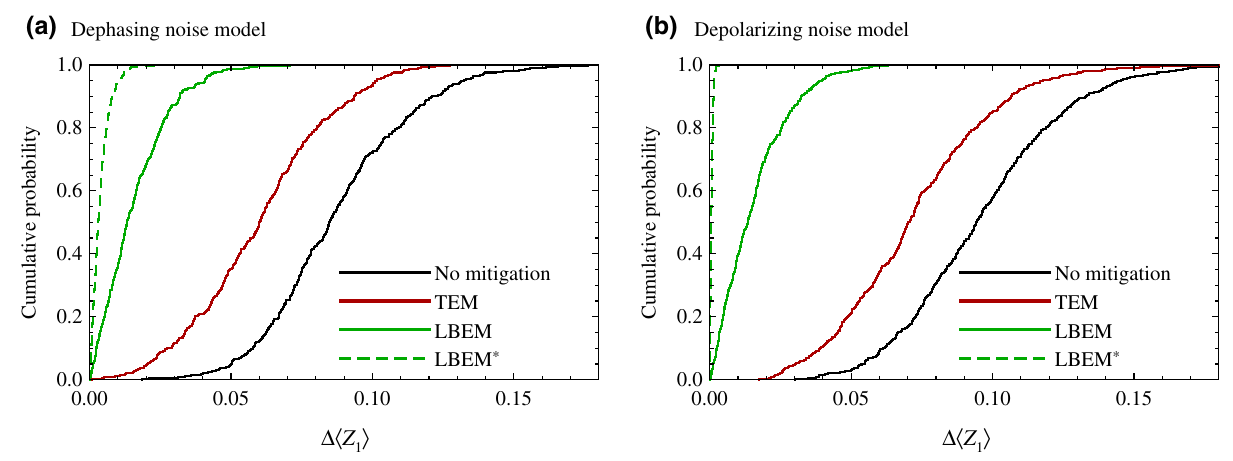
FIG. 2. Empirical cumulative distribution function of estimated (cid:7) (cid:10) Z 1 (cid:2) for 500 pseudorandom circuits with spatially correlated dephasing noise (a) and spatially correlated depolarizing noise (b). Results for circuits without error mitigation (black), with tomo- graphic error mitigation (TEM; red), and with learning-based error mitigation (LBEM; green) are presented. Additionally, we include the results for learning-based error mitigation when the sample size M → ∞ (dashed green).